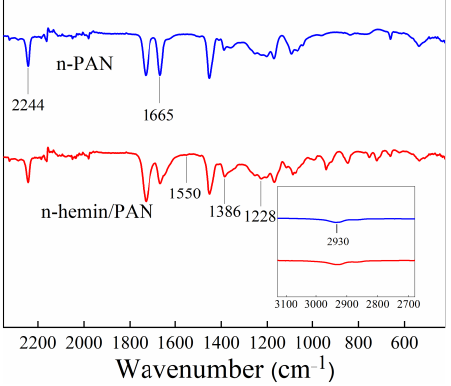
Figure 4. FTIR spectra of n-PAN and n-hemin/PAN.